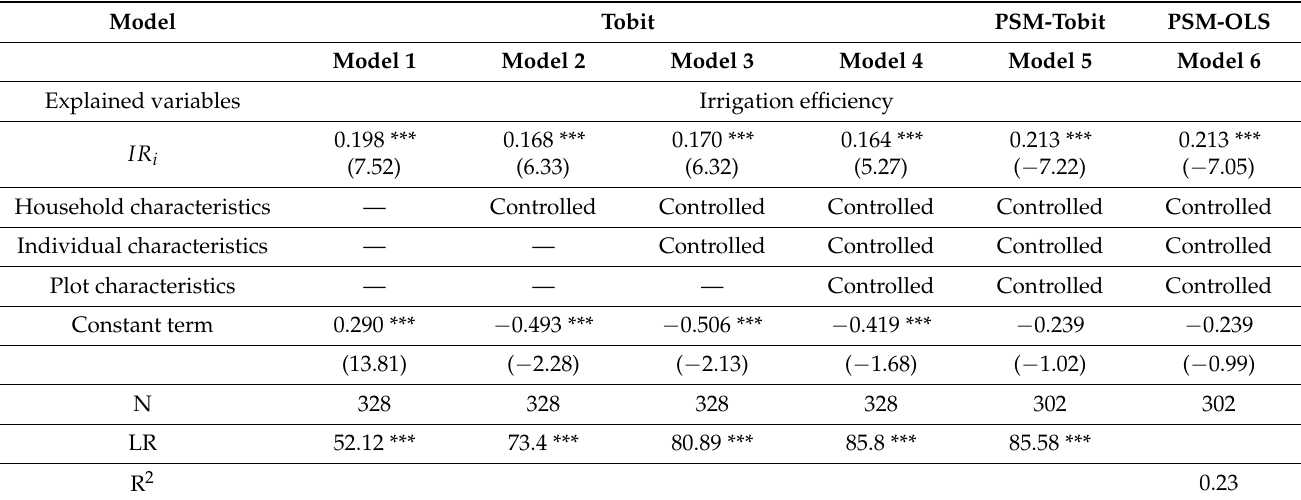
Table 4. Empirical analysis of the impact of property rights reform of farmland water facilities on the irrigation efficiency of farm households.